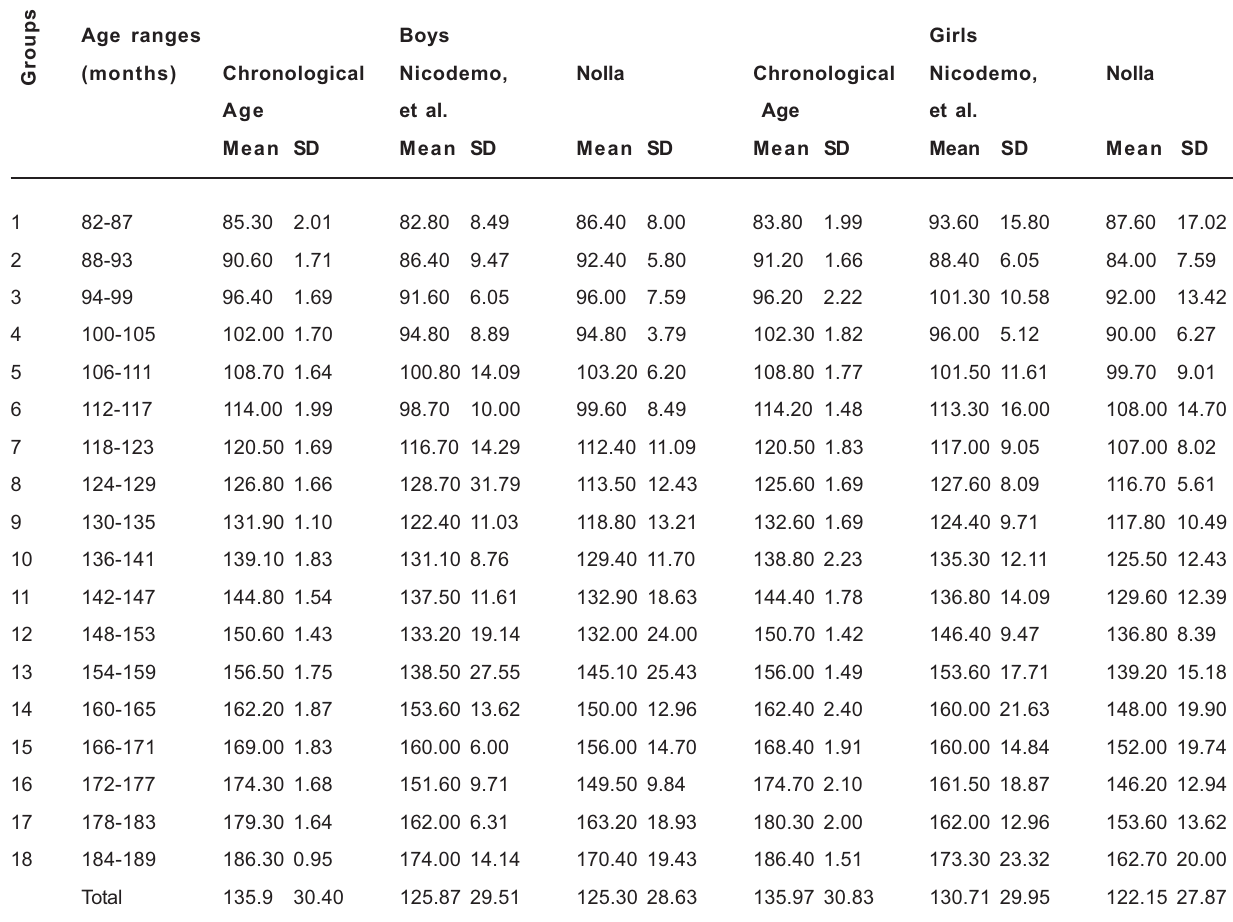
TABLE 1- Means (in months) and standard deviation (SD) of chronological age and estimated dental age using the methods proposed by Nolla and Nicodemo, et al. for Brazilian boys and girls